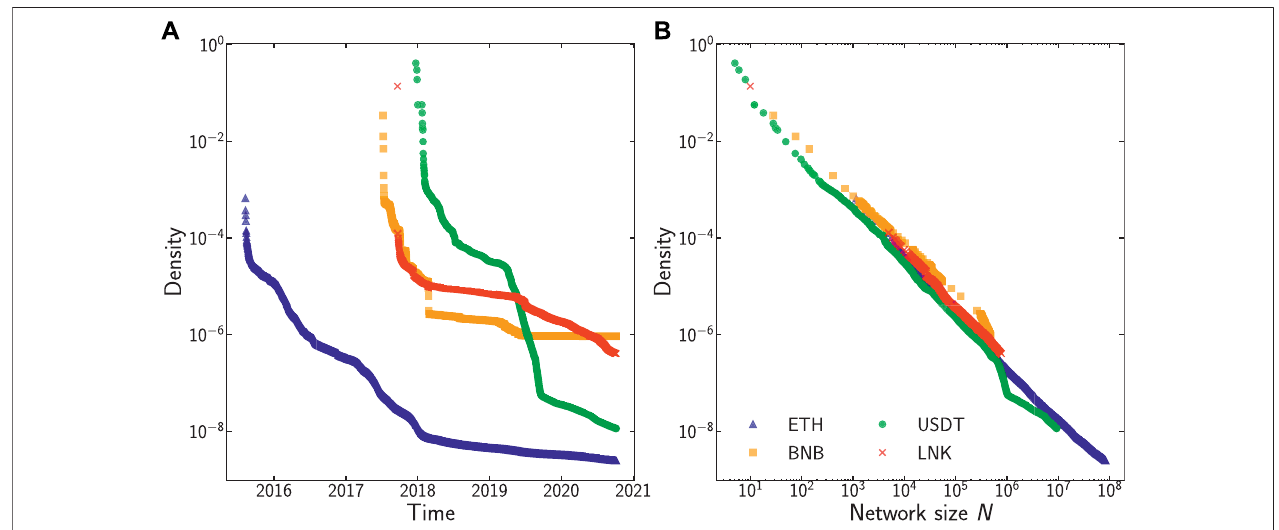
FIGURE3| Onthe (A), weshowthetimeevolutionofnetworkdensity,whileonthe (B), wehavethedensityasafunctionofthenetworksize.Both fi guresshowthe results for all the cryptoassets considered.